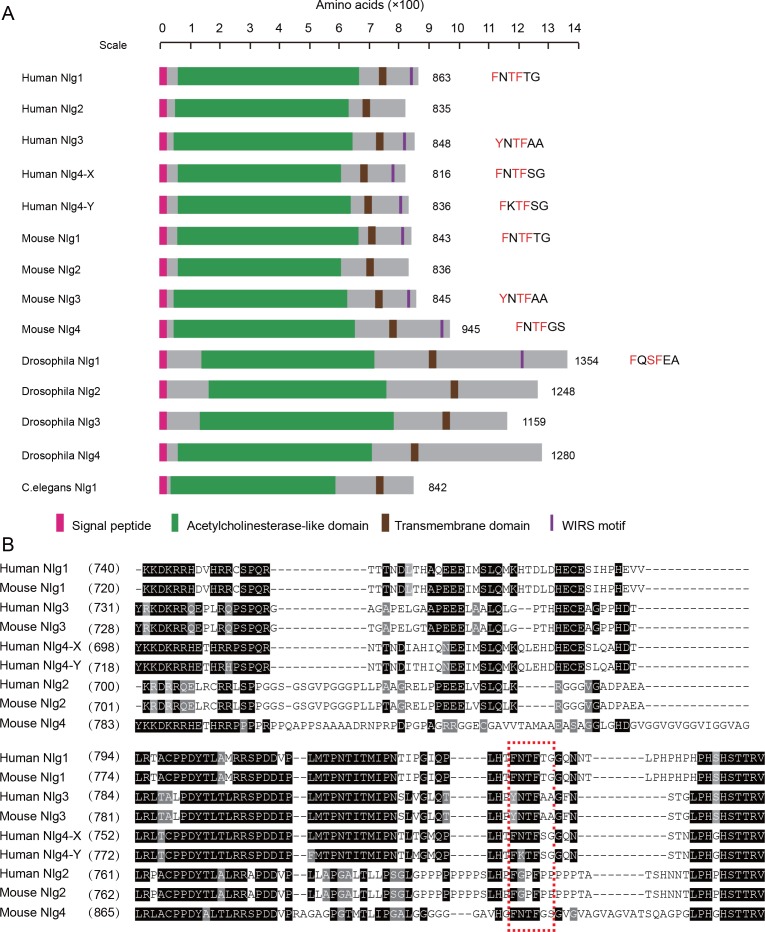
The WIRS motif is prevalent in neuroligins.(A) Sequence analysis of neuroligins from human, mouse, Drosophila, and C.elegans shows that WIRS is prevalent in neuroligins, especially in mammalian neuroligins. Neuroligin structures are indicated, and their WIRS motifs are marked if they have the motif. The WIRS sequence is also shown with the core amino acids highlighted in red color. (B) Sequence alignment of C termini of human and mouse neuroligins shows that Nlg1, Nlg3, and Nlg4 (Nlg4-X and Nlg4-Y) are more similar to each other than to Nlg2. Note that mouse Nlg4 is less conserved and was previously identified as an Nlg-like protein. The WIRS motif is highlighted by a red, dotted rectangle. Note that a core amino acid in the WIRS motif is mutated to P in Nlg2 and thus disrupts the property of WIRS.